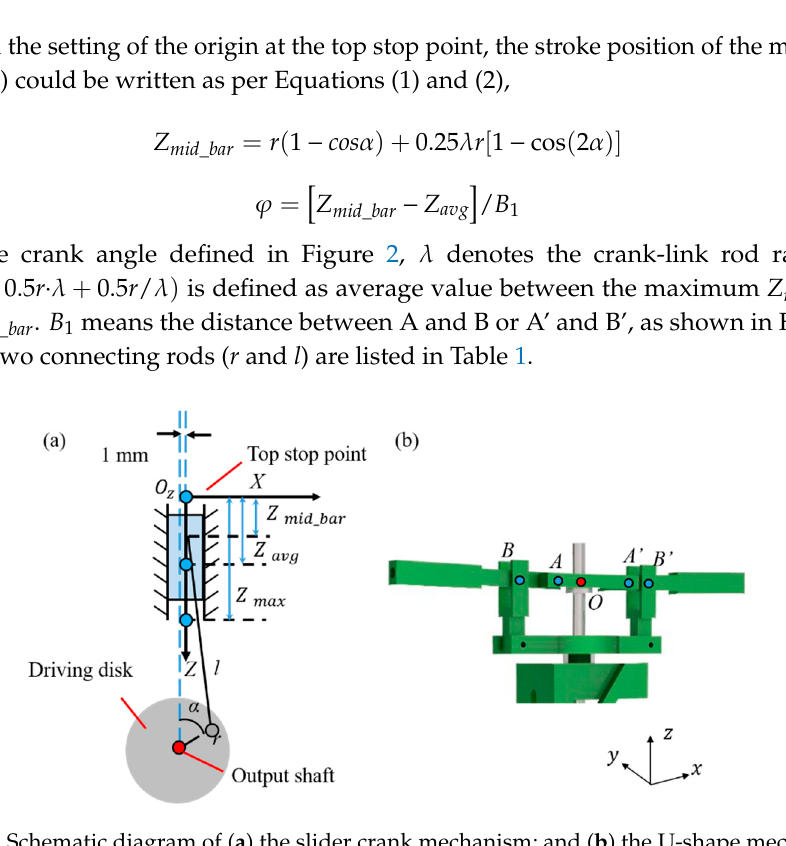
Figure 2. Schematic diagram of ( a ) the slider crank mechanism; and ( b ) the U-shape mechanism. Table 1. Geometric parameters for the flapping wing rotor’s mechanism.